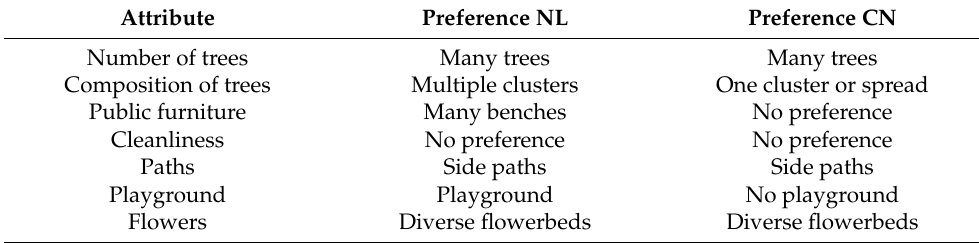
Table 6. Most preferred attribute levels per